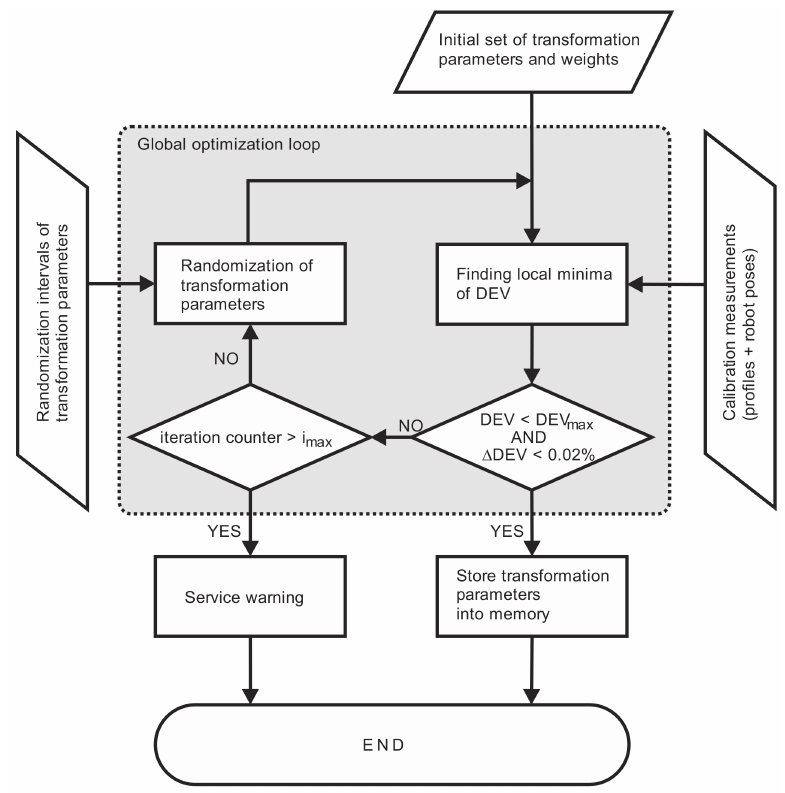
Figure 6. Flow chart of the calibration algorithm.